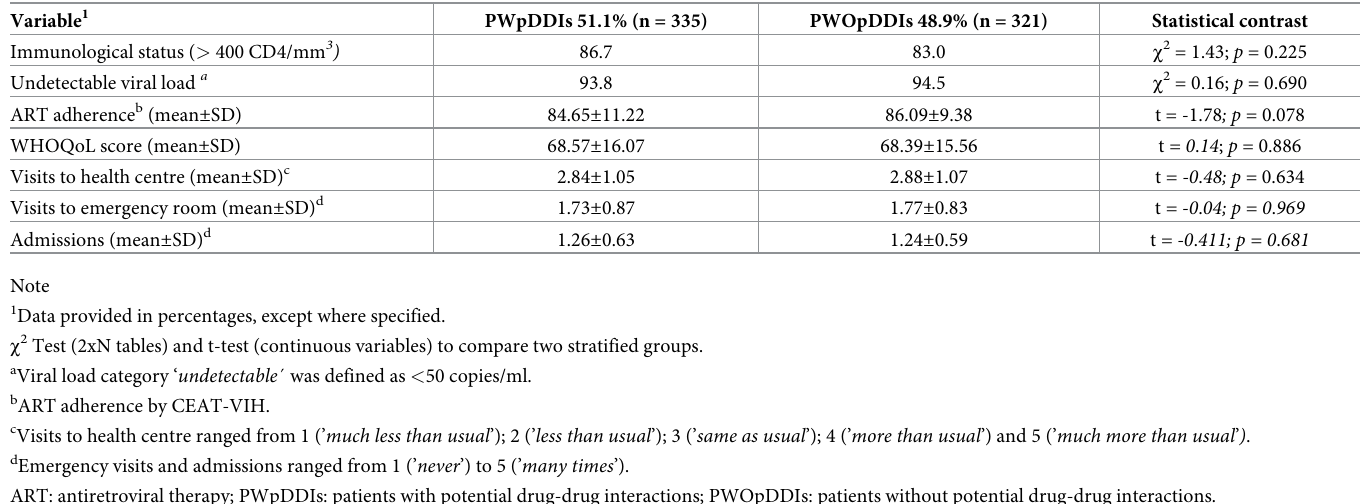
Table 5. Differences in health-related variables between participants with or without potential